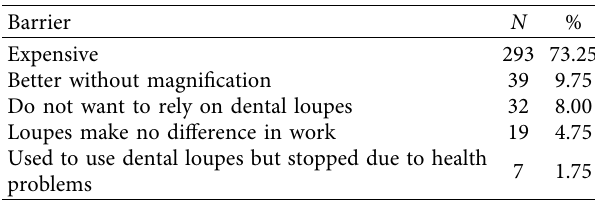
Table 4: Barriers to the use of dental